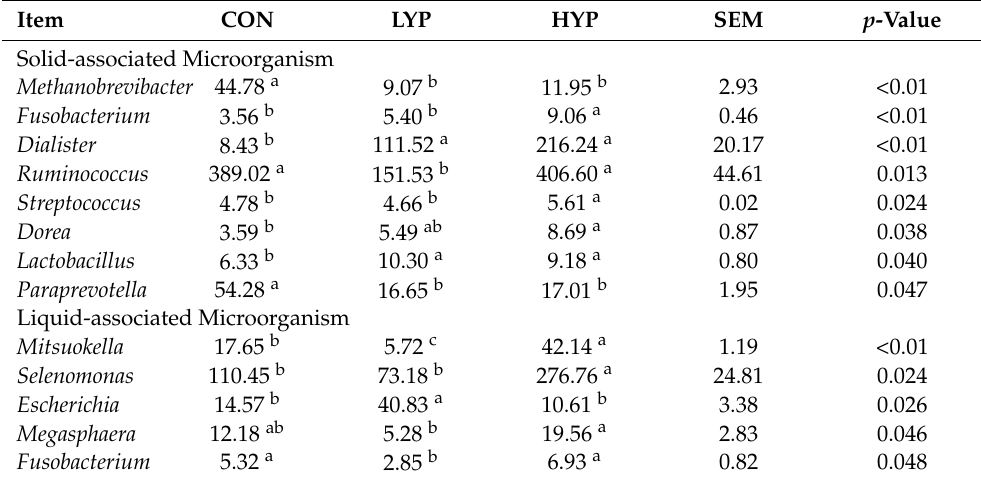
Table 2. Effects of yeast product on the top 50 species of relative abundance at the genus level in sheep